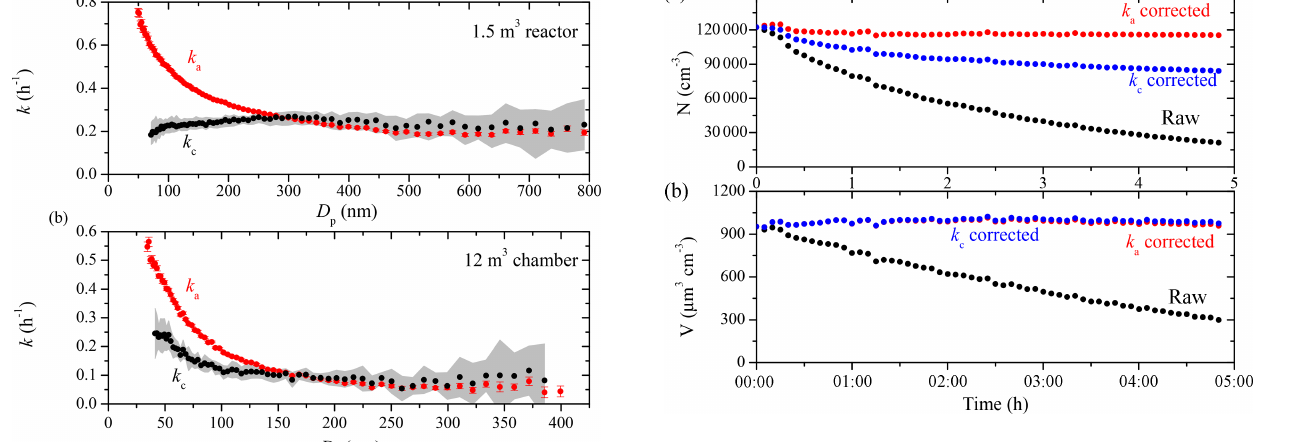
Figure 2. The SMPS-measured (black symbols) and the particle- loss-corrected (a) number and (b) volume concentration using the k a ( D p ) profile (red symbols) and the k c ( D p ) profile (blue symbols) for Exp.